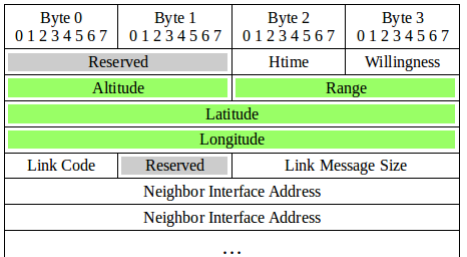
Figure 10. MHAR -OLSR Hello message